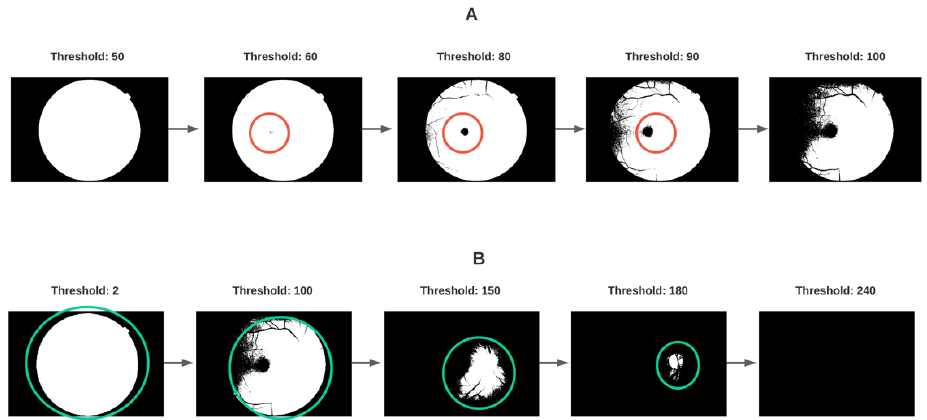
Figure 7. Visualization of binarized images from Figure 4B thresholded at grayscale values con- tained in the topological elements persisting for the largest amount of sublevel sets in the filtration represented by barcodes in Figure 6. Done for the bar in H 0 ( A ) and H 1 ( B ).